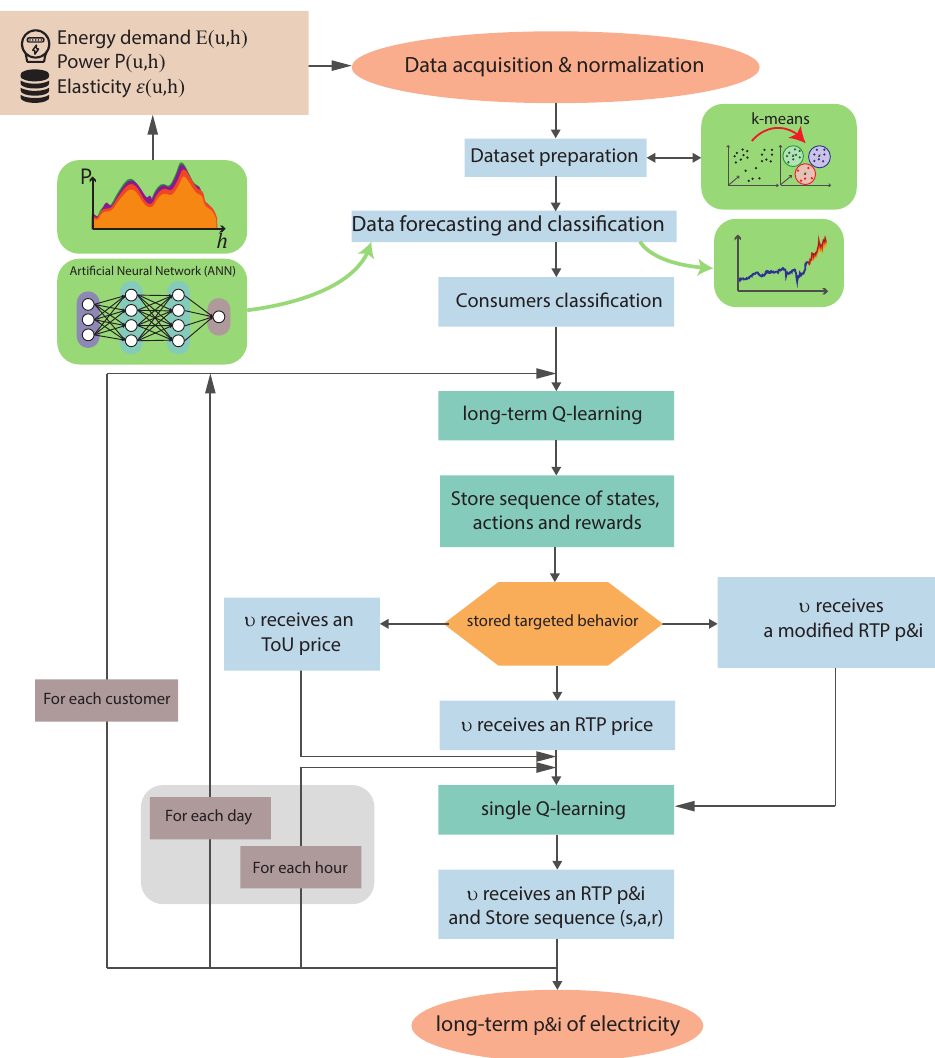
Figure 7. Flow Chart